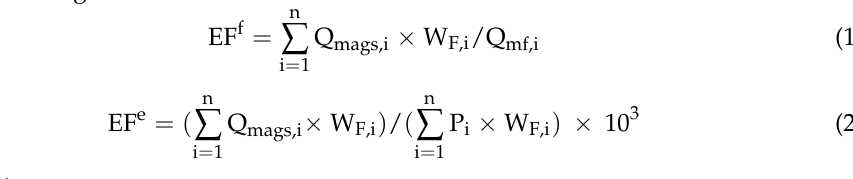
Table 1; i: test power point, as described in Table 1; EF e : energy-based emission factor (g/kW h); P: power of each test load point (kW).